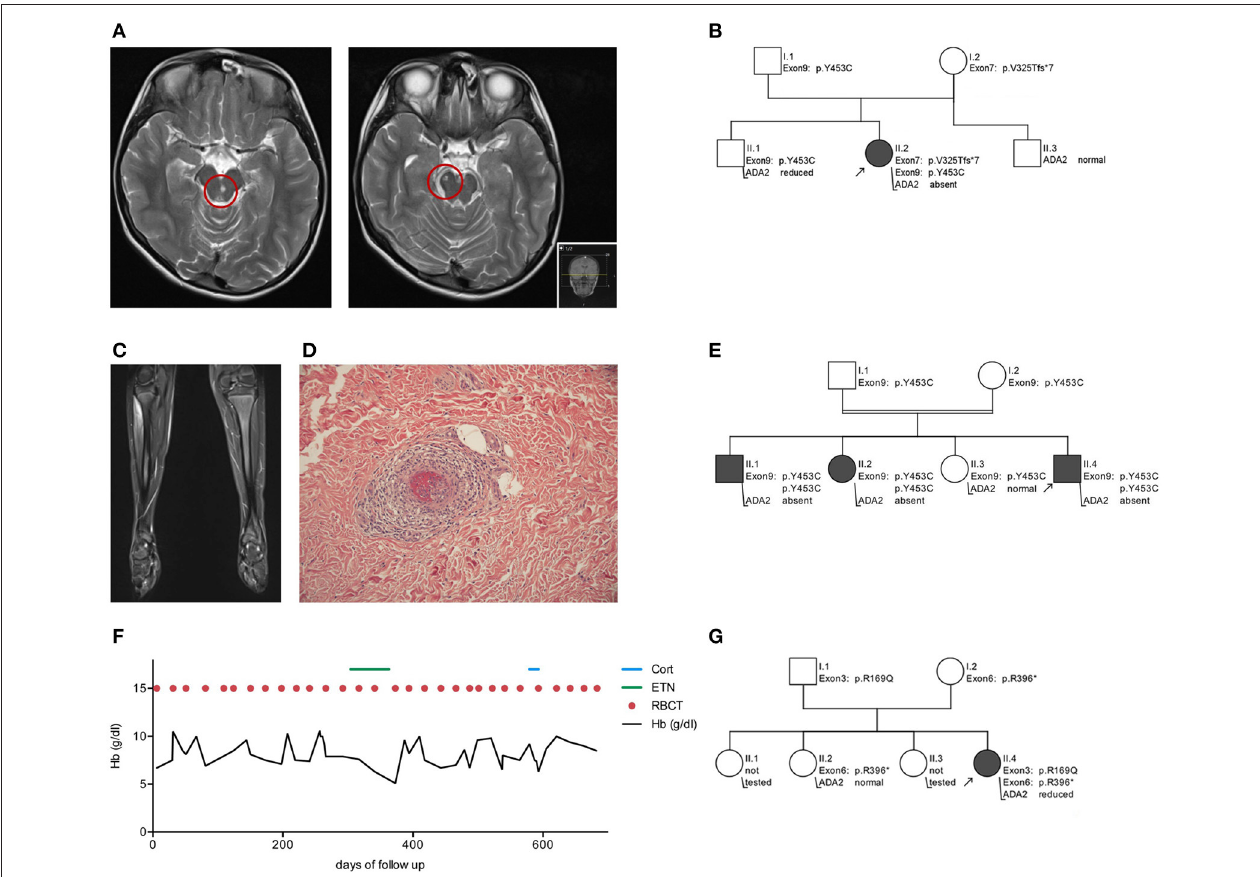
FIGURE 1 | Clinical features and pedigrees of patients with adenosine deaminase 2 deficiency. Patient 1 - Early-onset stroke (A) MRI of the brain showing two representative strokes in the mesencephalon right and paramedian left (red circles). (B) Illustration of ADA2 variant inheritance in family 1. Patient 2 - Polyarteriitis nodosa (C) MRI of the legs highlights myositis in the right tibialis anterior muscle. (D) In skin biopsy polyarteriitis nodosa presents as vasculitis of small cutaneous arteries. (E) Illustration of ADA2 variant inheritance in family 2. Patient 3 - Pure red cell aplasia (F) Hb course and transfusion sequence over 2 years of follow up. (G) Illustration of ADA2 variant inheritance in family 3. Hb, hemoglobin concentration; ETN, Etanercept; Cort, cortisol; RBCT, red blood cell transfusion; WT, wild type; Arrow, index